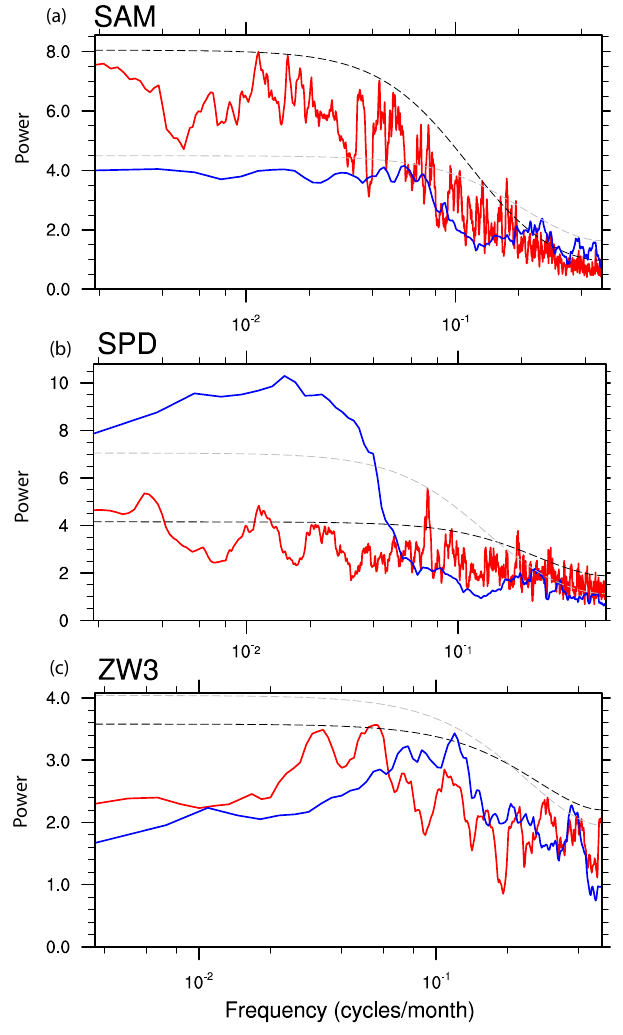
Fig. 3. Spectra of the monthly (a) SAM index, (b) SPD index and (c) ZW3 index calculated for both the CTRL1990 simulation (red) and for ERA-40 reanalysis data (blue). The dashed lines indicate the 95% confidence levels based on a Markow red noise spectrum with the same variance for the CTLR1990 simulation (black) and the ERA-40 data (gray).